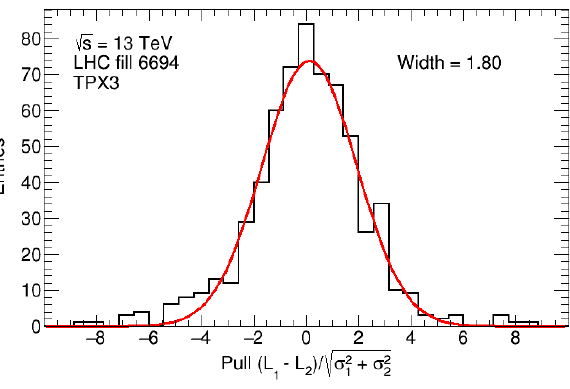
(cid:113) + σ 2 σ 2 , where σ i is the luminosity uncertainty 2 1